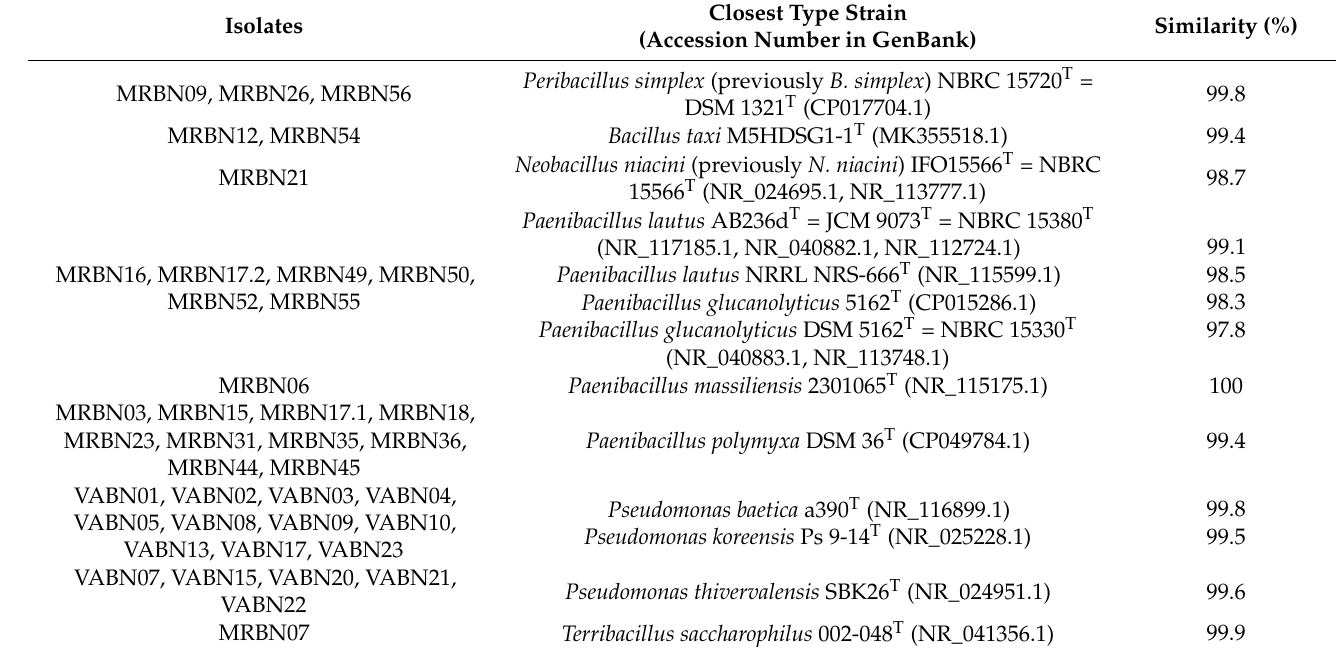
Table 2. Results of the rrs gene sequence